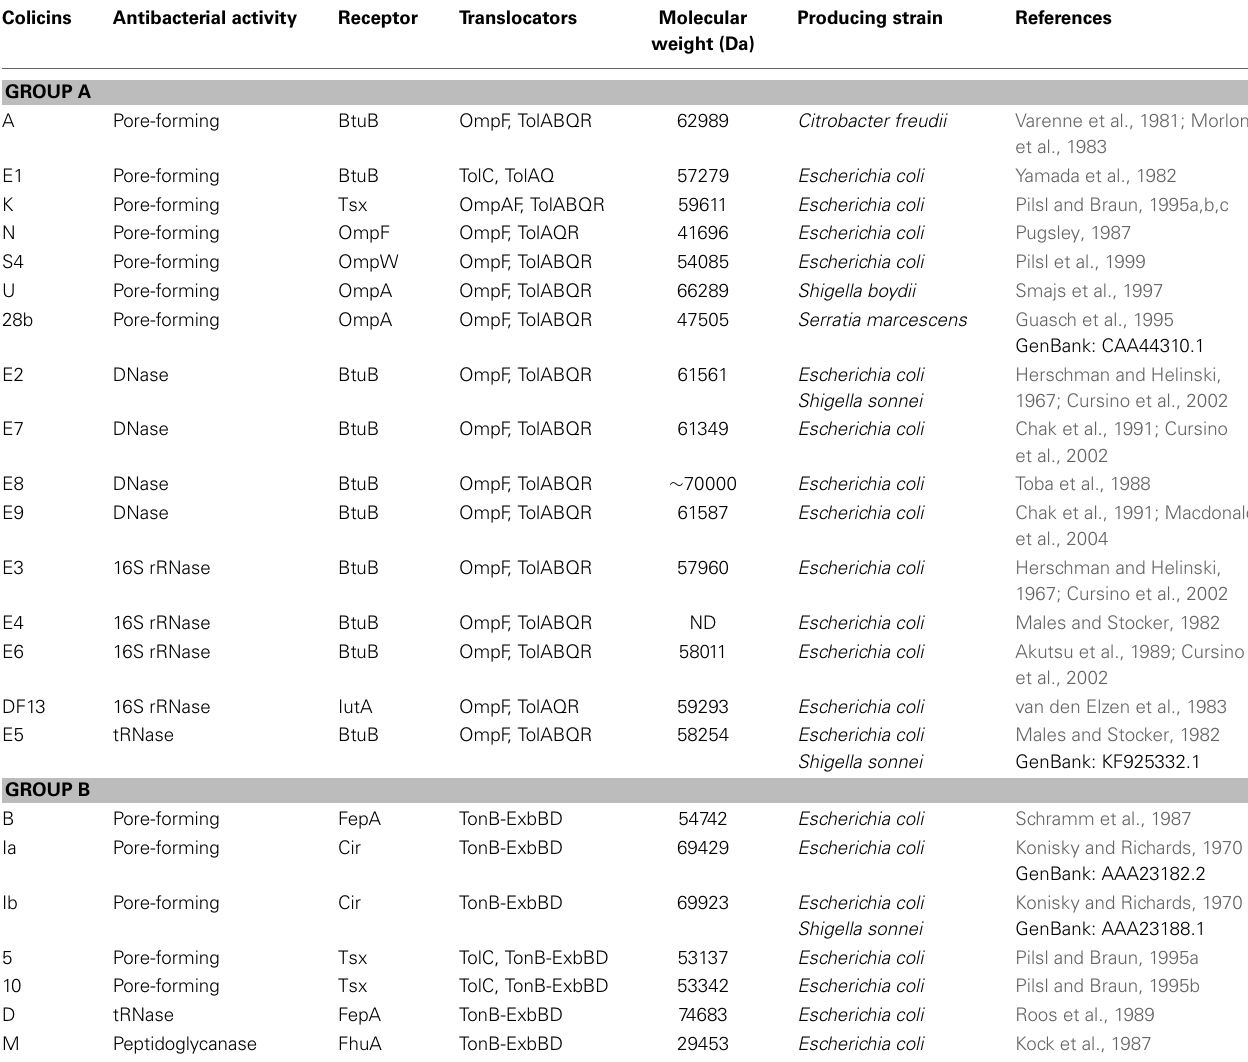
Table 1 | Classification of colicins by different translocators system: Tol- and Ton-dependent in the E. coli .